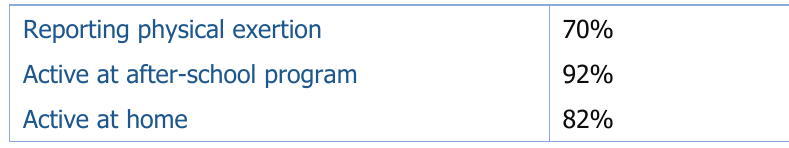
Table 4. Percentages for Youth’s Daily Active Play